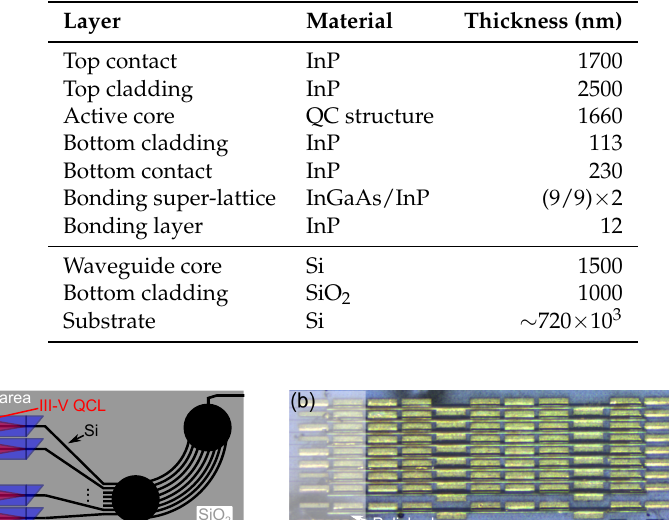
Table 1. Quantum cascade laser (QCL) layer structure.